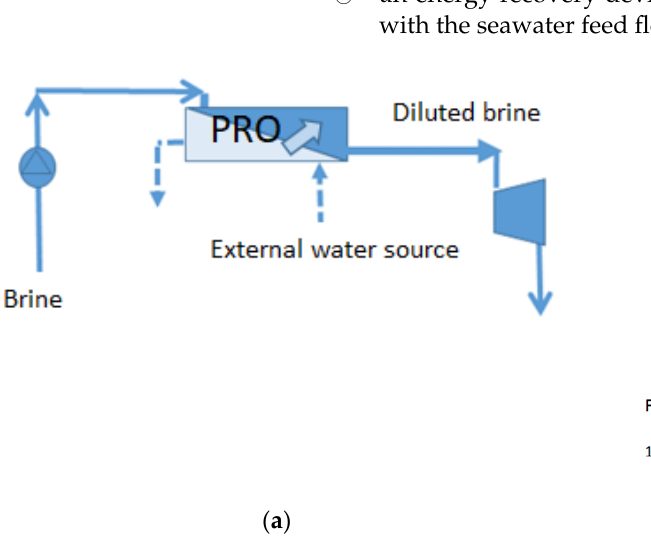
Figure 2. Energy production from pressure retarded osmosis by pressurizing water transferred through the membrane elements. ( a ) Conceptual diagram of electricity production. ( b ) A possible combination of PRO and RO desalination with two turbo chargers (TC) as energy recovery devices.